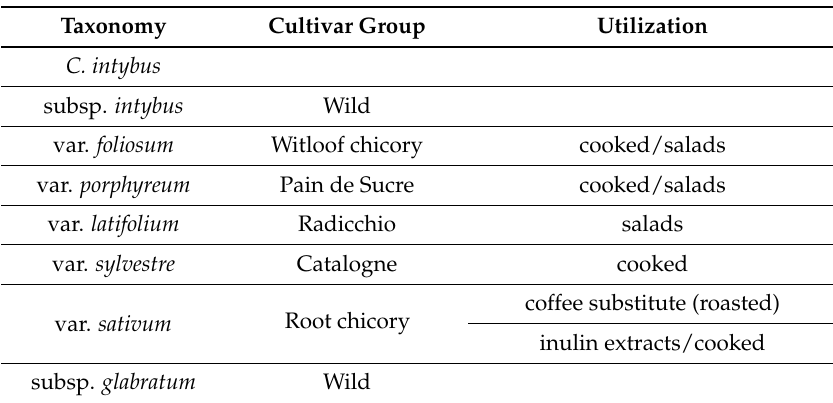
Table 1. Taxonomy of Cichorium intybus , including subspecies, botanical varieties, and cultivar groups (adapted from Lucchin et al.